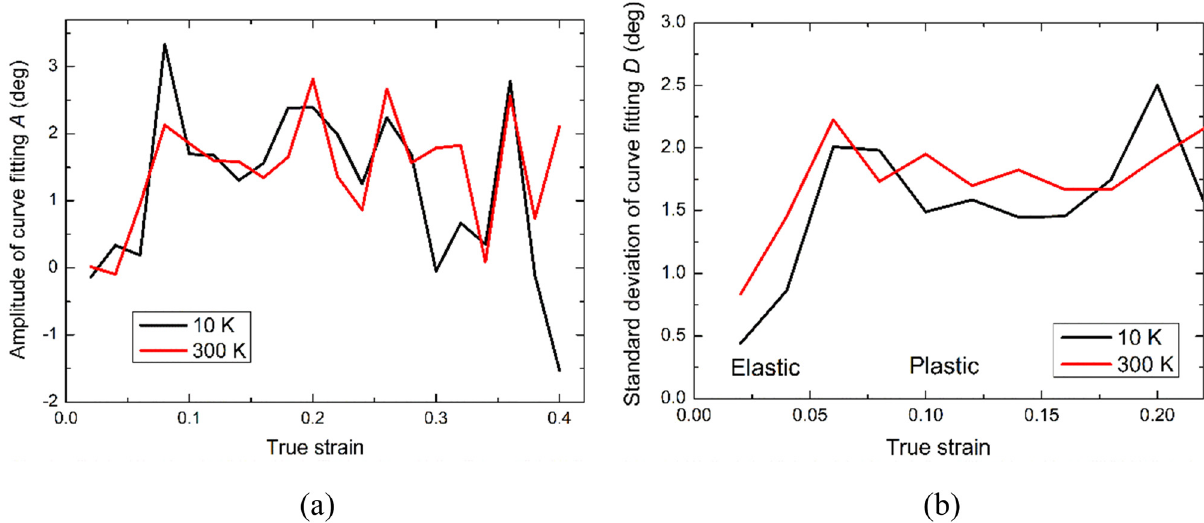
Figure 13: Temperature e ff ect on ( a ) the amplitude and ( b ) the standard deviation of the curve fi tting for the initial orientation dependence of grain rotation